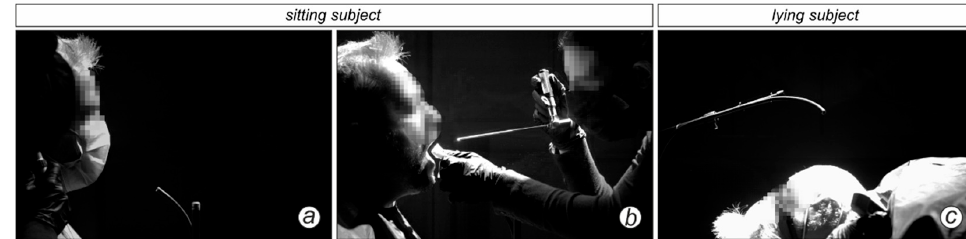
Figure 2. High-speed camera view on three exemplary tasks. ( a ) Otoscopy; ( b ) Rigid laryngoscopy through the mouth without a mask. ( c ) Sonography (supine) with MNC.